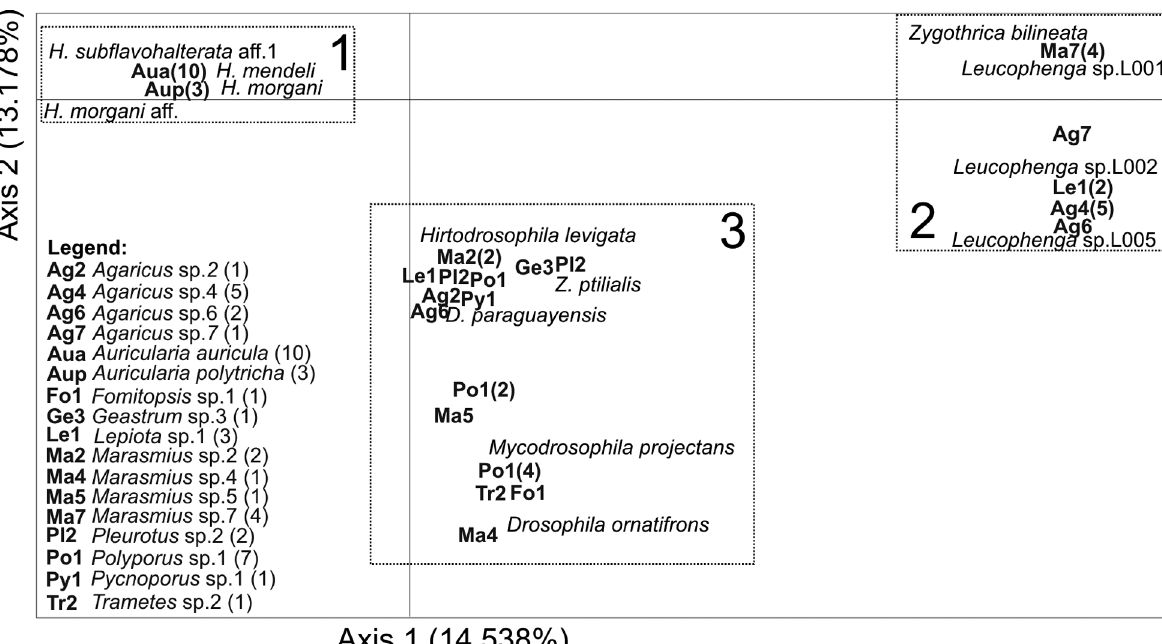
Figure 5 - Axis 1 and 2 of the correspondence analysis (CA) relating the species of drosophilid and host fungal species from which they emerged. Samples of fungi are shown in bold. The number of samples used in the CA is shown in brackets in the legend. The numbered squares represent independent groups of drosophilid species according the analysis of similarity (ANOSIM).